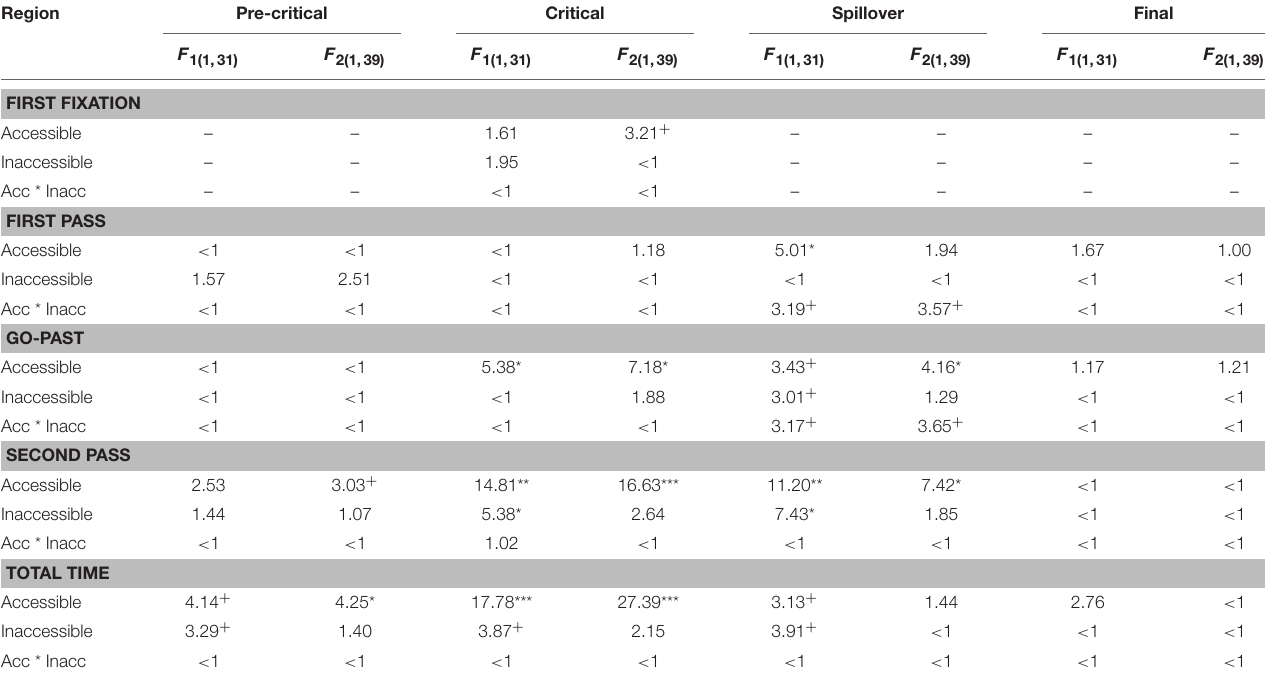
TABLE 6 | Anova results for Experiment 3 ( + p < 0 . 1 ; * p < 0 . 05 ; ** p < 0 . 01 ; *** p < 0 . 001 ).